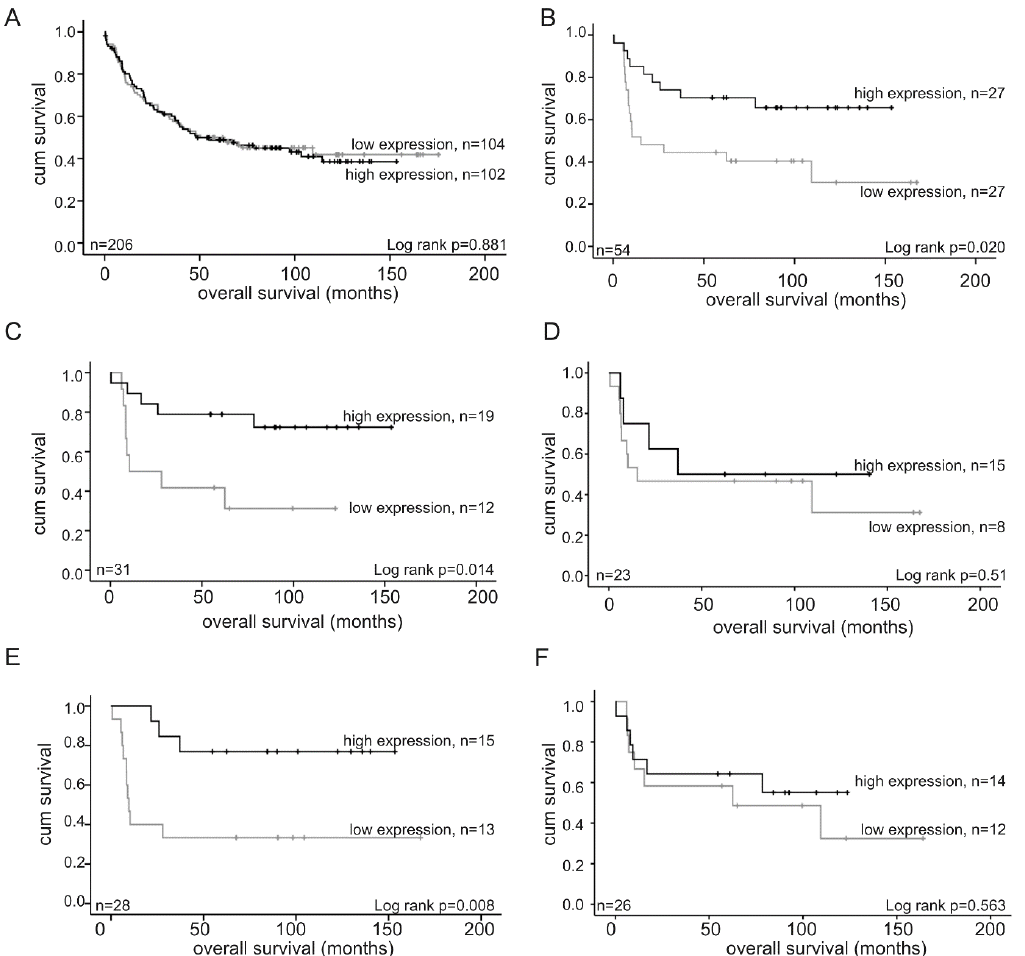
Figure 3. Impact of ORP3 mRNA levels on prognosis of colon cancer patients. ( A ) ORP3 mRNA levels in the whole cohort of colon cancer patients in correlation to patient´s survival, ( B ) ORP3 mRNA levels in grade 3 human colorectal patients in correlation to patient’s survival; ( C , D ) ORP3 mRNA levels in grade 3 tumors in correlation to female ( C ) and male ( D ) colon cancer patient’ survival; ( E , F ) ORP3 mRNA levels in grade 3 human colorectal patients in correlation to patient’s age, ( E ) patients younger than 70 years old and ( F ) patients older than 70 years old. ORP3 mRNA levels were determined by quantitative gene expression analysis in the whole cohort and in the subgroup of patients with grade 3 colon cancer. Patient’s cumulative survival was plotted against ORP3 mRNA levels. The median value was used to group patients with high and low ORP3 expression. Statistical analysis: Exploratory data analysis was performed using IBM SPSS Statistics 25 (SPSS Inc., Armonk, NY, USA). For statistical analysis of overall survival, Kaplan–Meier estimations were created and a significance was tested using log-rank test. p -values < 0.05 were considered statistically significant. No correction for multiple testing was done. Black: high ORP3 expression levels, grey: low ORP3 expression